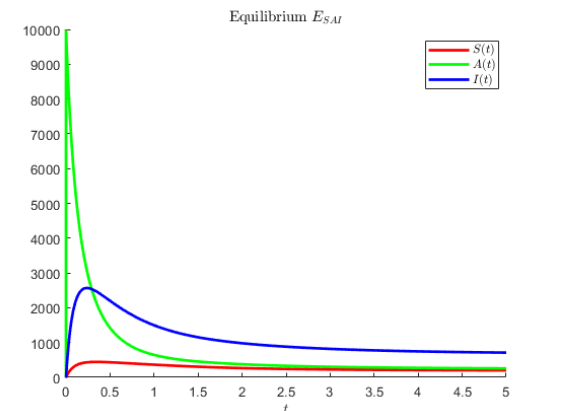
Figure 4. Coexistence equilibrium for model (23) obtained with parameter values (55), (51) and initial conditions